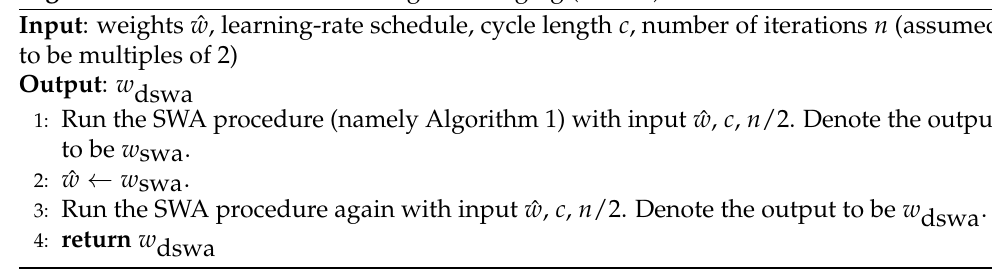
Algorithm 2 Double Stochastic Weight Averaging (DSWA)